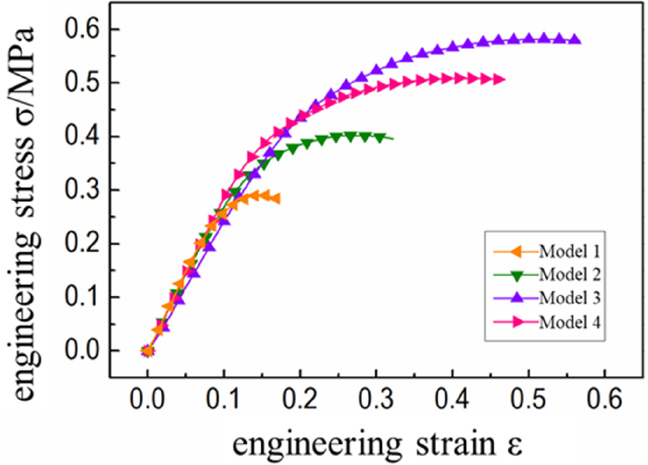
Figure 6. Stress-strain curves of propellants with different particle sizes. Table 5. Mechanical property of propellants at different gradations.